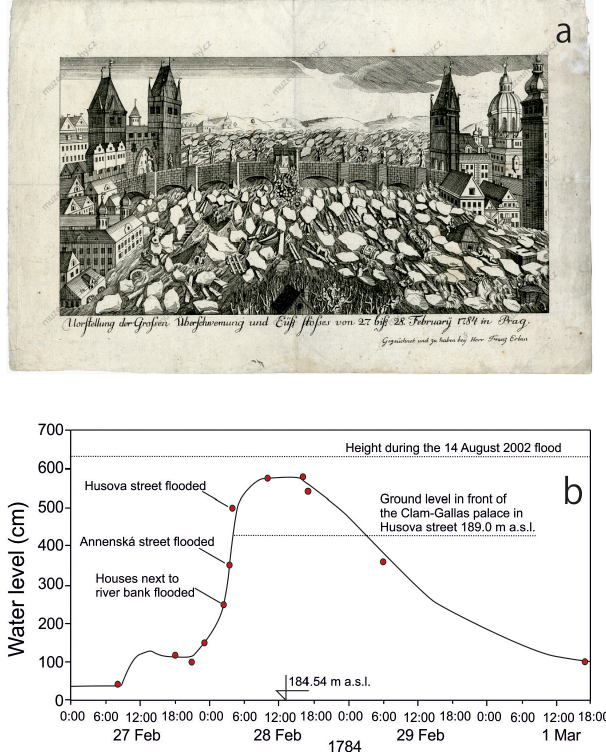
Figure 5. (a) Pictorial representation of the River Vltava during the February 1784 flood, showing ice floes and woody debris ac- cumulated at the Charles Bridge in Prague (copperplate by F. Er- ban, Museum of the City of Prague, catalogue no. 125.387). The ice jams at the bridge caused flooding upstream resulting to the high- est known water marks until the August 2002 flood (Brázdil et al., 2005a). (b) A flood hydrograph of the Vltava River in Prague at the Monastery of the Knights of Cross reconstructed from documentary data for 27 February–1 March 1784 with an estimated discharge rate of 4560m 3 s − 1 (Brázdil et al.,